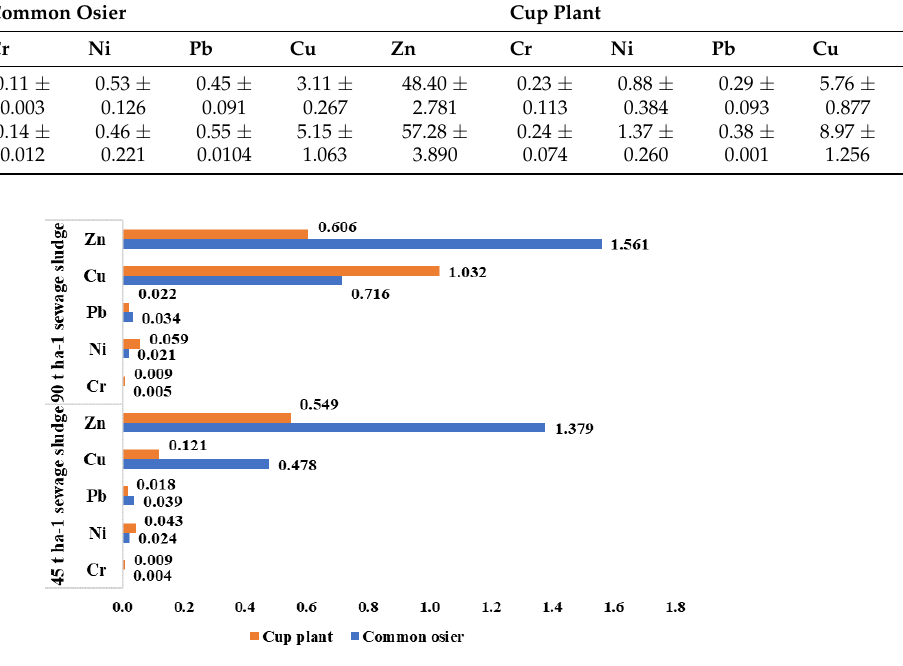
Figure 3. Bioconcentration factor of heavy metals under different rates of sewage sludge applica- tion.